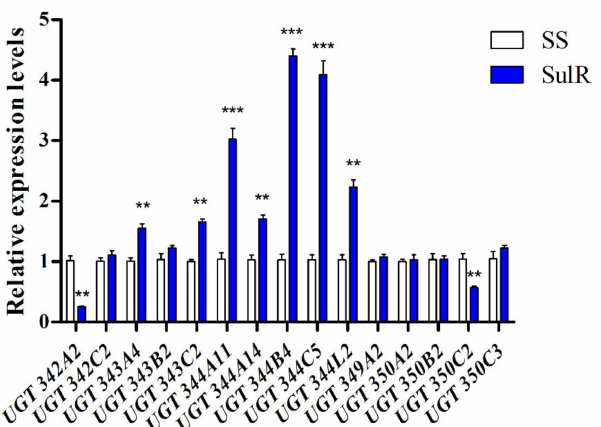
Figure 1. Relative expression levels of UGT genes in adult aphids of the susceptible and sulfoxaflor resistant strains. Data are presented as the mean ± SD for at least three independent replicates. ** indicates significant differences as analyzed by Student’s t -test ( p < 0.05); *** indicates significant differences as analyzed by Student’s t -test ( p <